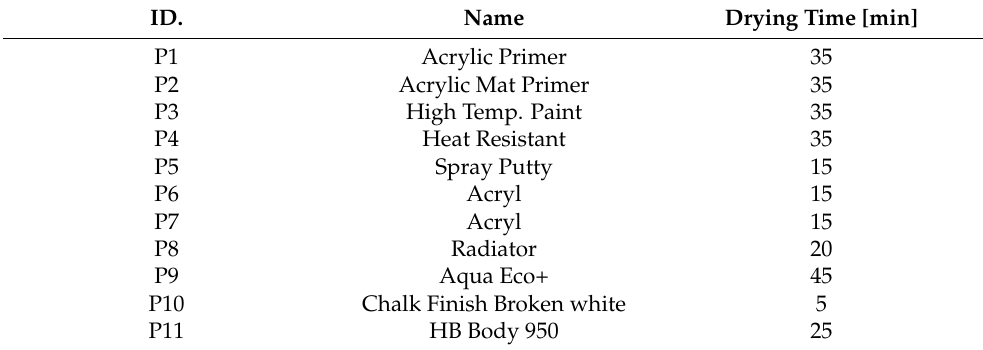
Table 6. Results of the touch test.